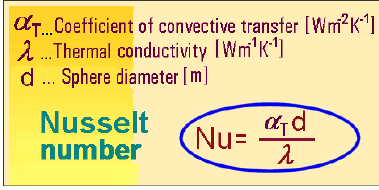
Intensity of heat transfer by convection is non- dimensionalised by comparing it - in the magnitude of Nusselt number – with the conduction heat transfer